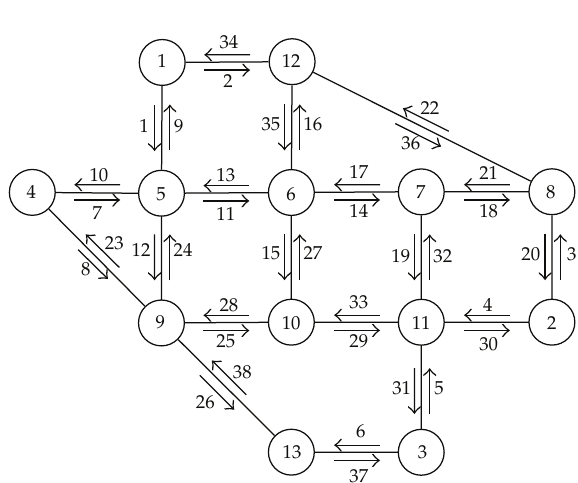
Figure 5: Nguyen-Dupuis tra ffi c network